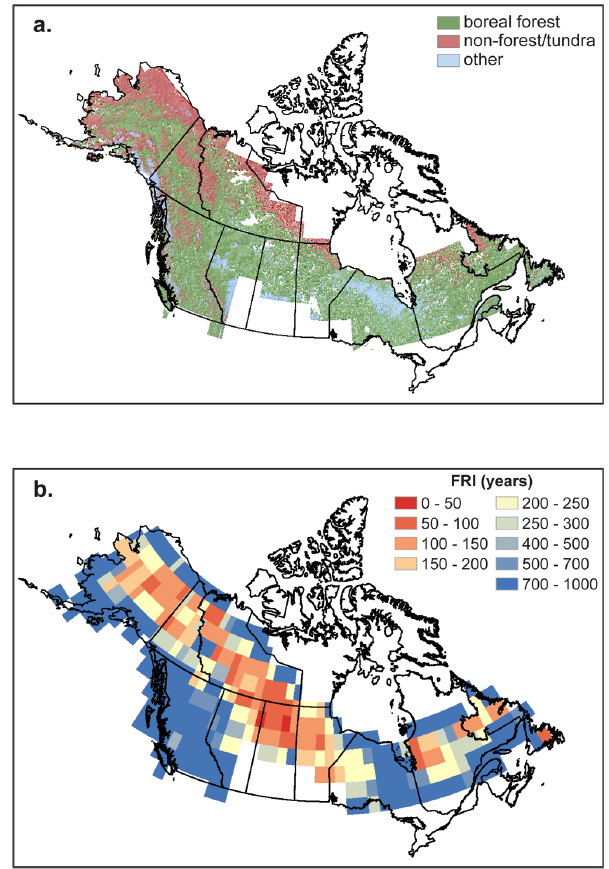
Fig. 1. 500m land cover classification (a) and historical (1961– 2010) mean boreal forest fire return intervals (FRIs) (b) within 2 ◦ CLM grid cells in the North American boreal domain. Vegetation composition varied within the boreal forest fraction of grid cells as a function of FRI, and remained static